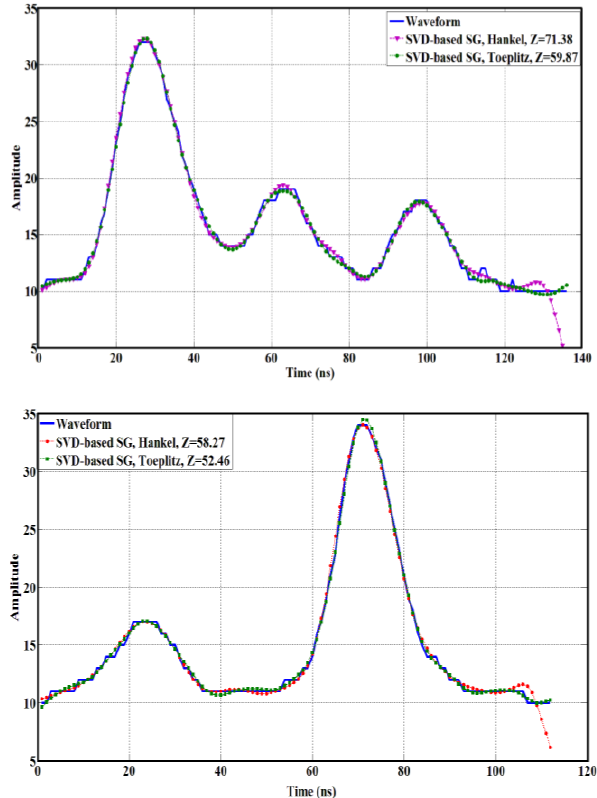
Figure 5. Comparison of the SVD-based S-G filters for Hankel and Toeplitz form of two noisy waveforms, along with their corresponding cost function values (Z) A simple quantitative comparison based on the value of the utilized cost function confirms that S-G filtering outperforms MA filtering in terms of producing a smaller discrepancy between the filtered and original waveform. This implies that the SVD-based S-G filter preserves both the moments and, principally, the amplitude of the